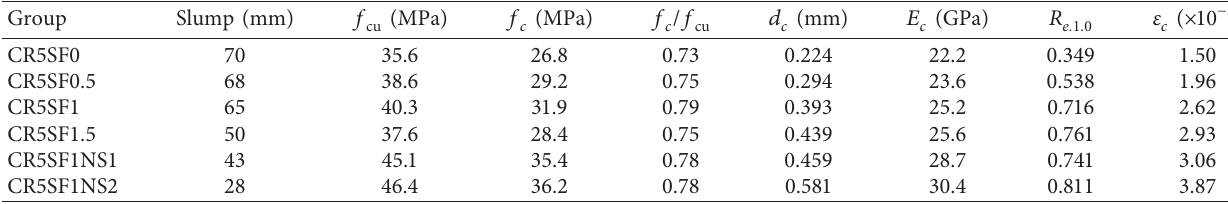
Figure 4: Testing arrangement for stress-strain curves: (a) general view; (b) Table 5: Test results.